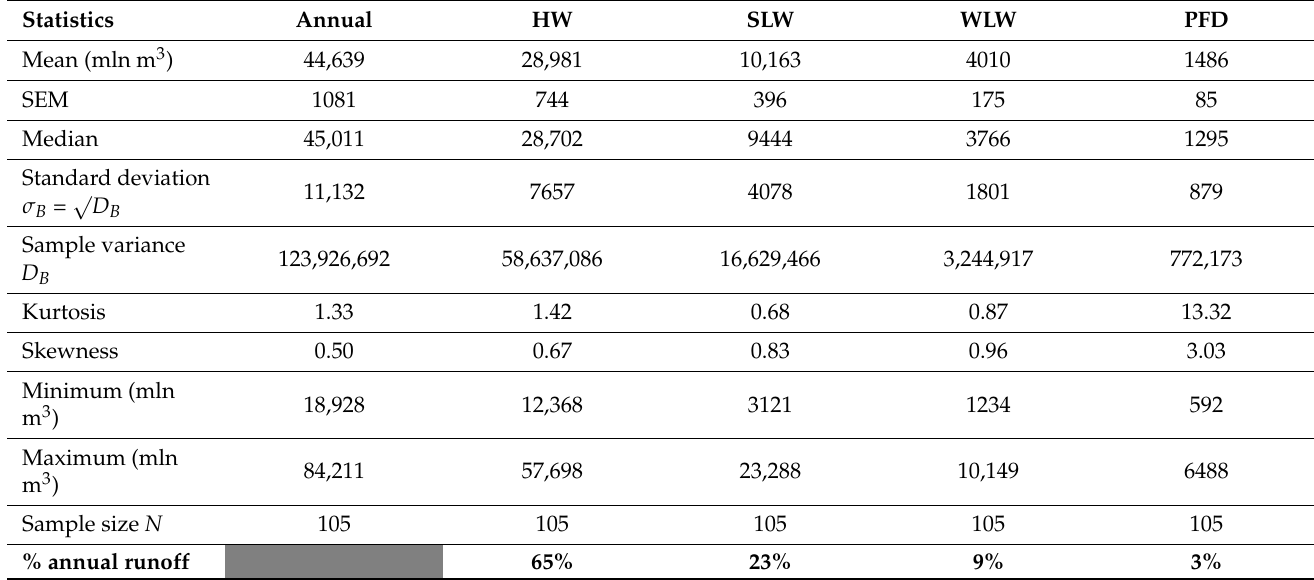
Table 3. Numerical characteristics of the inflow distributions for 1916–2020 (Kuibyshevskoye reser- voir).